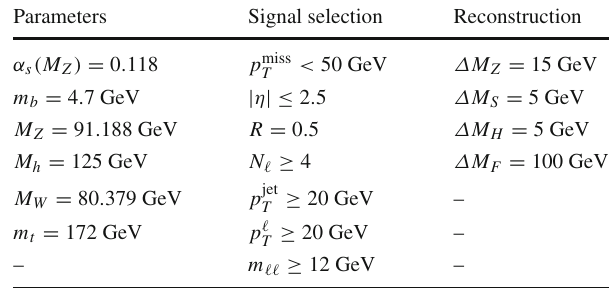
Table 1 Decay modes of the VLLs through the S scalars, (10) and (11), giving rise to a final state with four light leptons after ¯ ψ